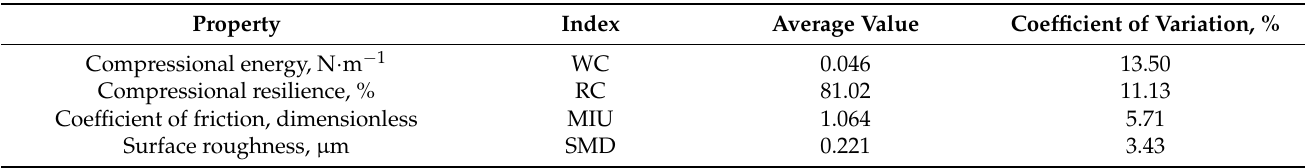
Table 2. Mechanical properties of polyurethane material without ultrasonic joint. WC, compressional energy; RC, compres- sional resilience; MIU, coefficient of friction; SMD, surface